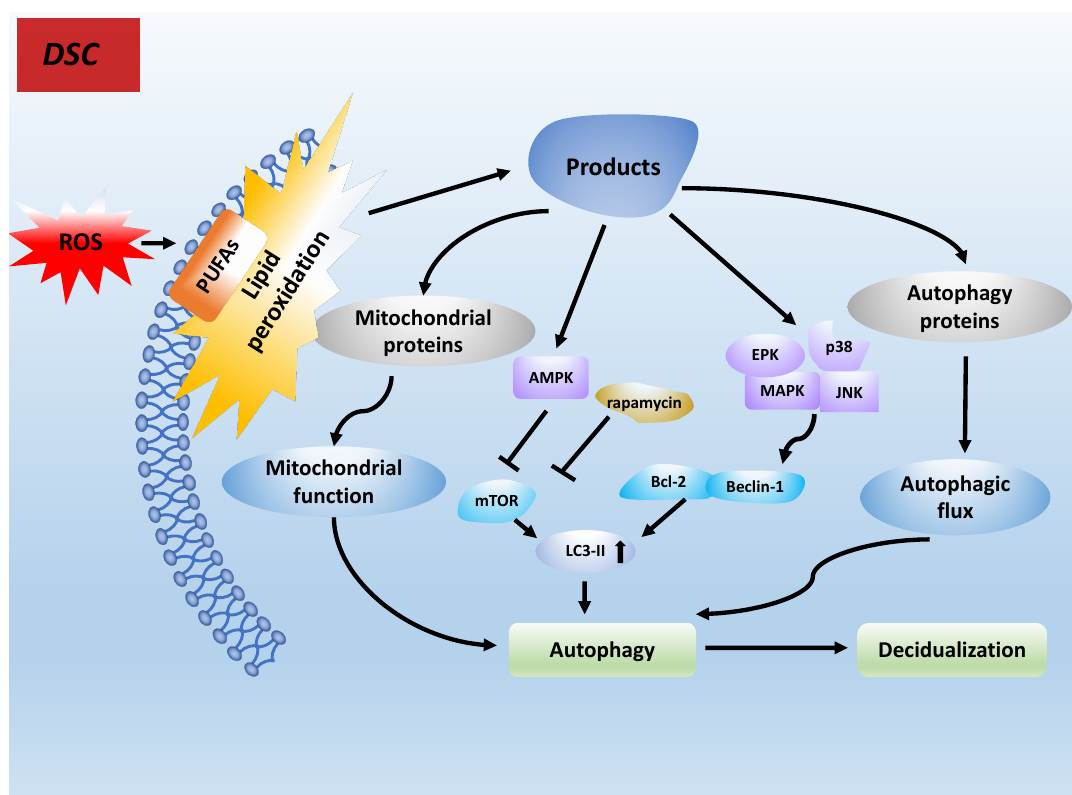
Figure 3. Lipid peroxidation products can adduct specific mitochondrial and autophagy-related proteins, which can result in autophagy and cell death